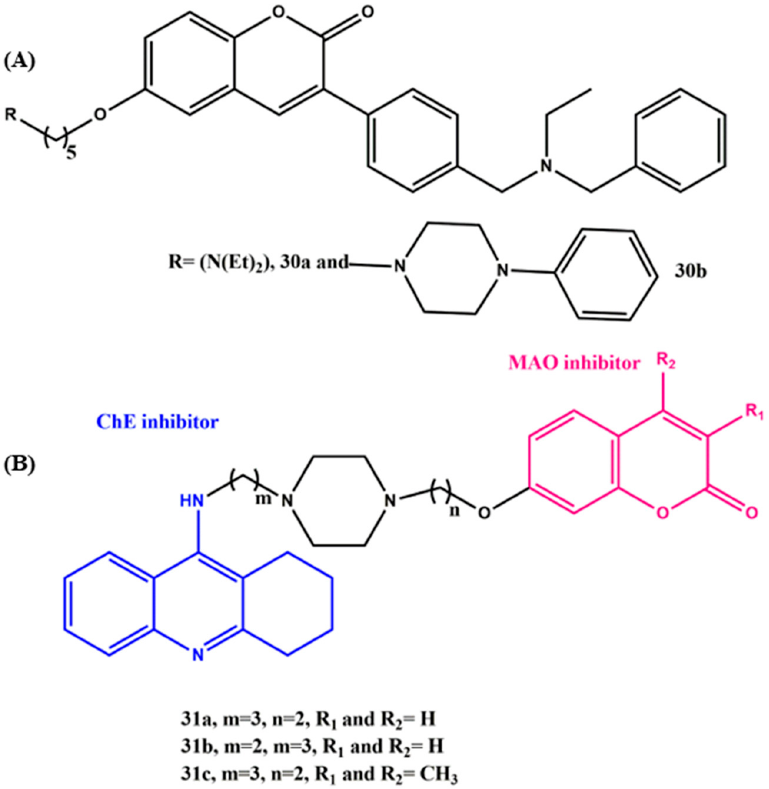
Figure 12. ( A ) and ( B ) Chemical structures of coumarin-derived MTDLs for AD.